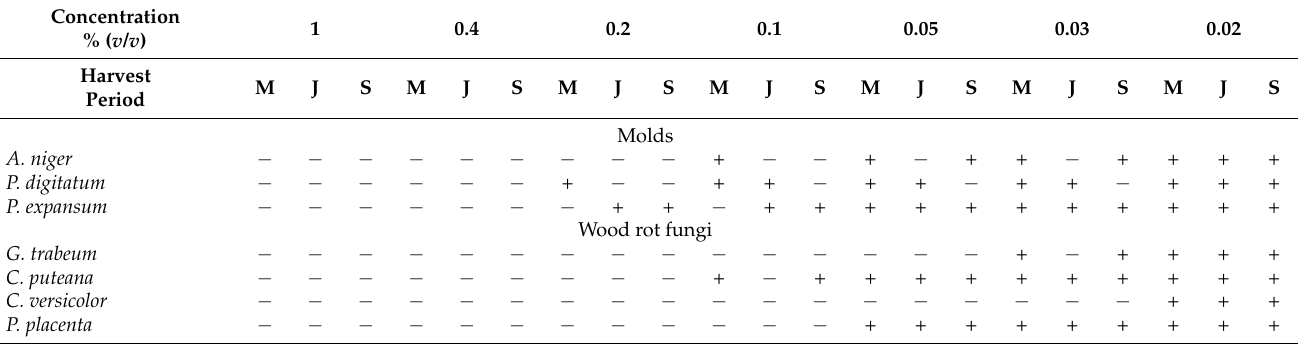
Table 5. Determination of MIC values of Artemisia herba-alba essential oil against molds and wood rot